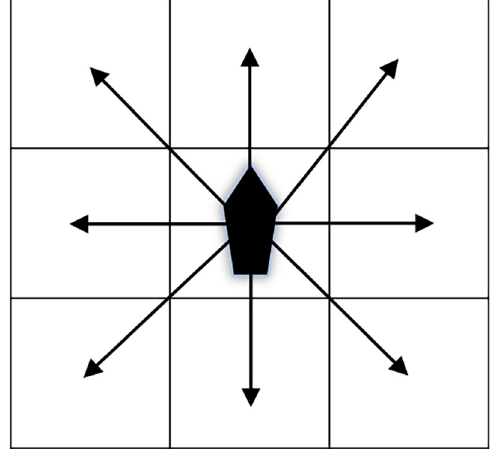
Figure 3 8-directional search pattern of A (cid:1)